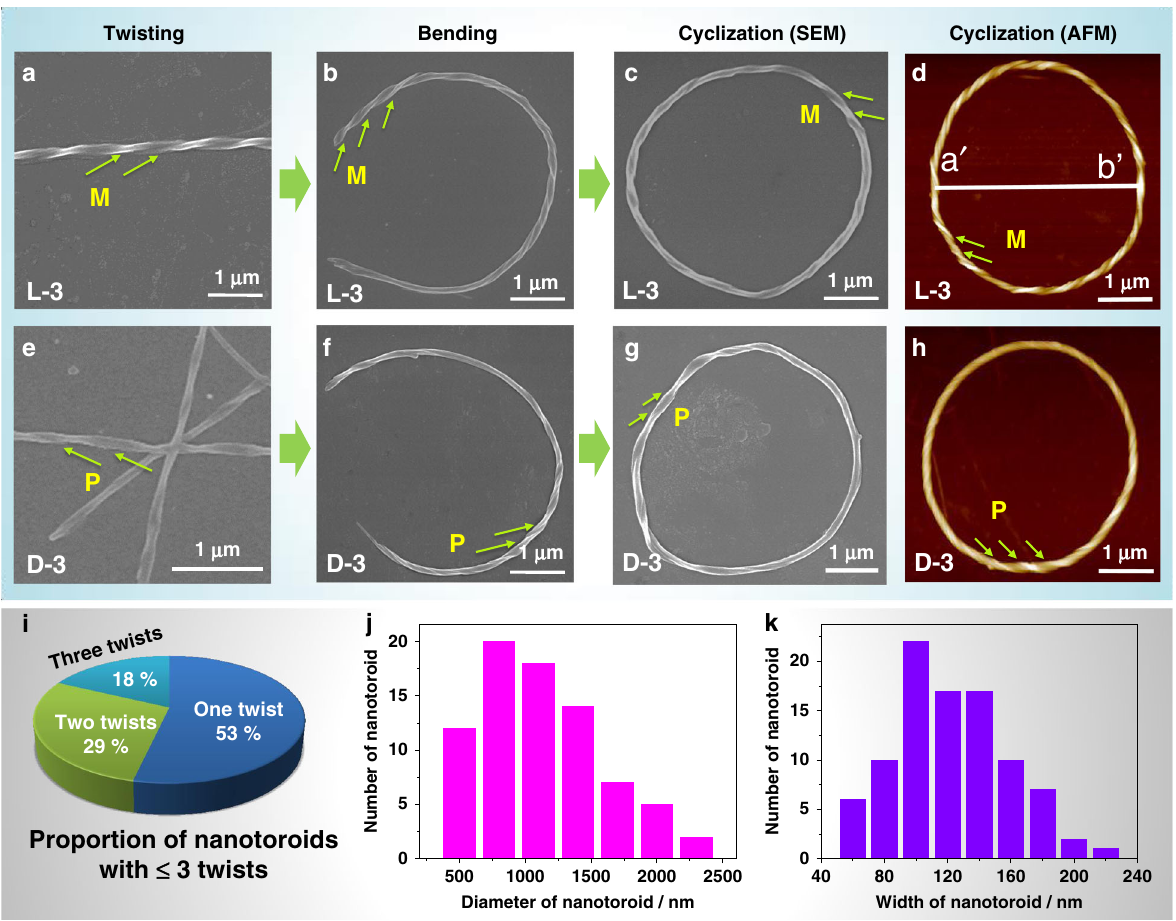
Fig. 2 Bending and cyclization processes of twisted nano fi bers revealed by electron microscopic images and statistical analysis of chiral toroidal fi bers. SEM and AFM images of L-3 self-assemblies showing M chirality. a Linear twisted fi ber. b Semicircle shaped twisted fi ber. c , d Chiral toroidal fi bers, the diameter (a ′ – b ′ ) of toroid showed in ( d ) is about 4.0 μ m. SEM and AFM images of D-3 self-assemblies showing P chirality. e Linear twisted fi ber. f Semicircle shaped twisted fi ber. g , h Chiral toroidal fi bers. [L-3] = [D-3] = 0.11 mM, pH = 3 for ( a ) and ( e ), pH = 2 for ( b – d ) and ( f – h ). Notes: M means left helicity and P means right helicity. i – k Statistical analysis of morphological properties of nanotoroids observed from SEM images of L-3 self-assemblies (total number of nanotoroids analyzed, 95). i Proportion of nanotoroids with ≤ 3 twists on the toroidal fi bers, the number of toroids with one, two, and three twists are 16, 8, and 5, respectively. j The frequency distribution histogram is plotted against the diameter of nanotoroids. k The frequency distribution histogram is plotted against the width of